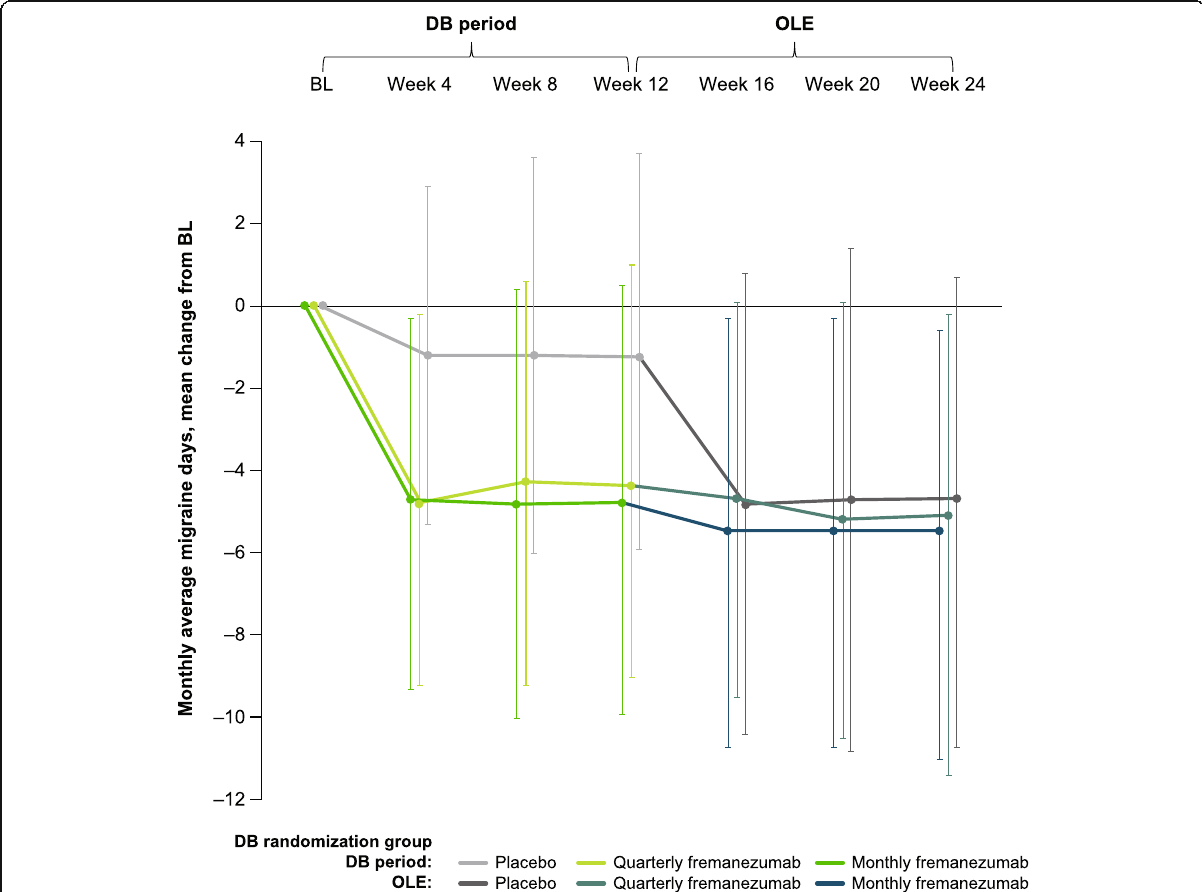
Fig. 2 Mean change from BL in the monthly average number of migraine days over 6 months (mITT). a BL, baseline; mITT, modified intent-to-treat; DB, double-blind; OLE, open-label extension. a All patients in the OLE received fremanezumab 225 mg